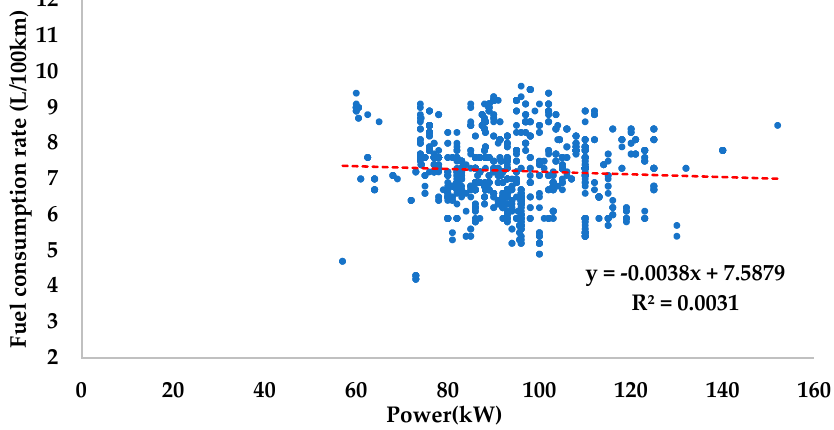
Figure 5. Regression results of power and fuel consumption rate of models in the 1300–1400 kg curb weight class.